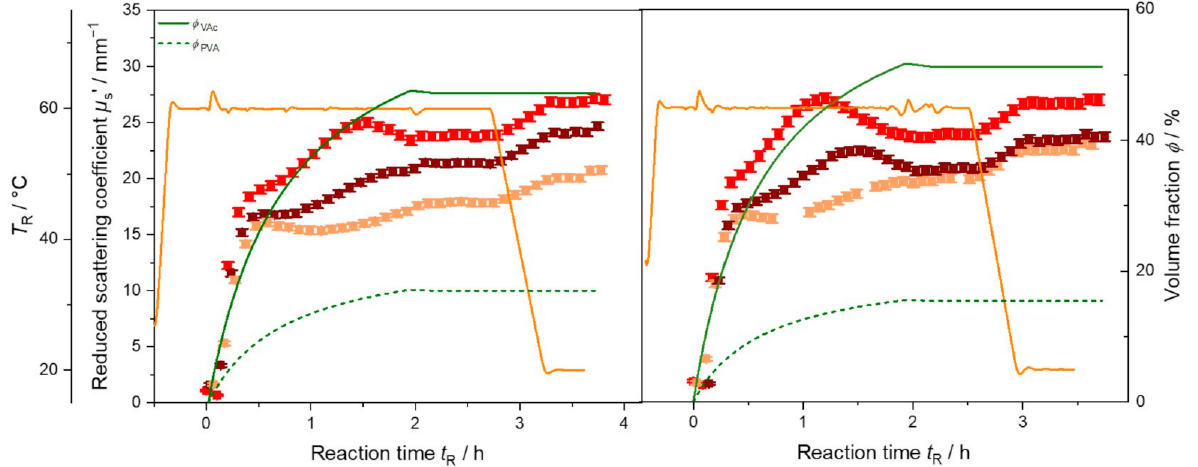
Figure 5. Reduced scattering coefficient µ s ’ (symbols) at λ = 637 nm (red), λ = 690 nm (brown) and λ = 751 nm (orange), volume fraction of dosed monomer φ VAc and protective colloid φ PVA (solid green and dashed lines, respectively), and reaction temperature T R (orange line) as function of time during polymerization of VAc for synthesis VAc_1.5 (left) and synthesis VAc_1.8